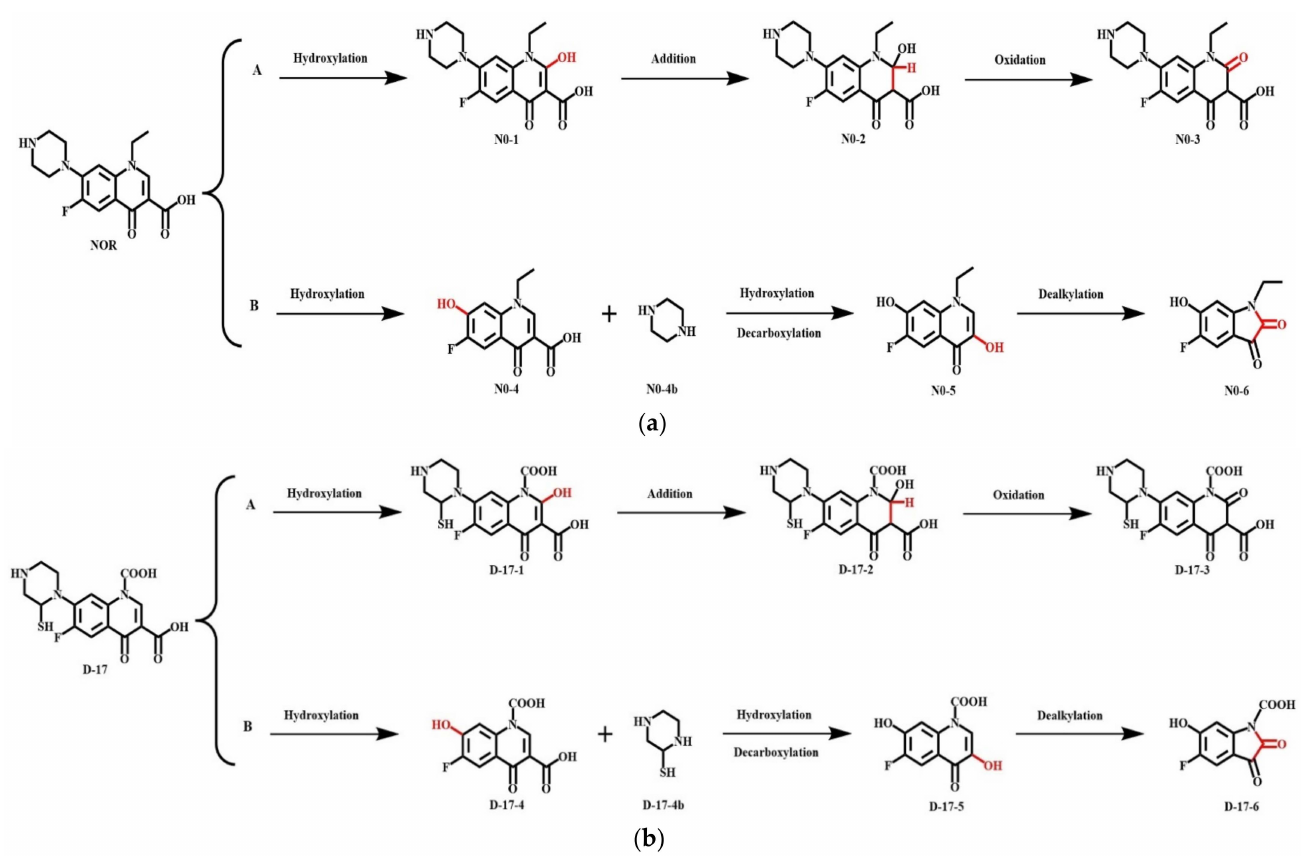
Figure 8. Simulation of the plant degradation pathways of ( a ) NOR; and ( b ) its derivative D-17. Table 8. Calculation of the ∆ E for the plant and microbial transformation pathways of NOR and its derivative D-17.